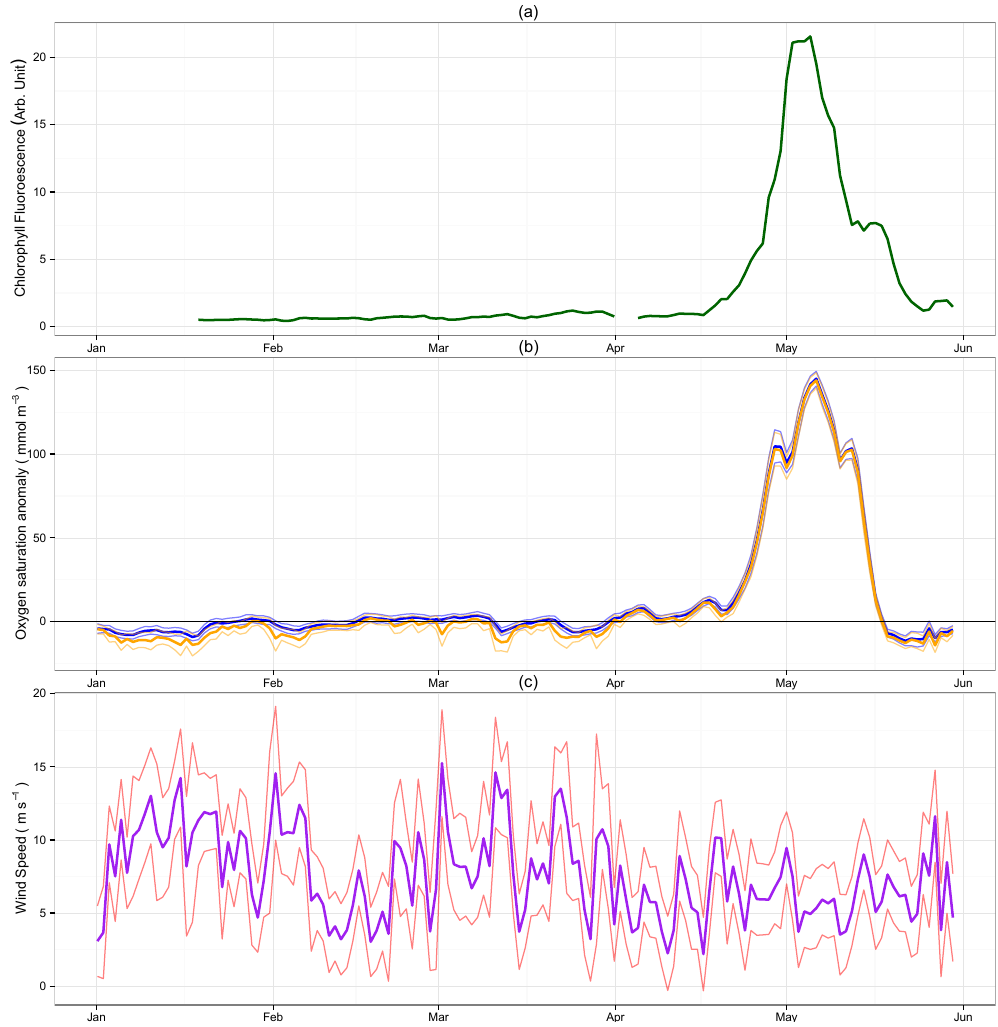
Figure 3. Spring 2008 Warp Anchorage time series. (a) Chlorophyll fluorometry. (b) Oxygen saturation anomaly (oxygen concentration mi- nus the solubility). Orange and blue lines represent oxygen saturation anomaly with and without bubble supersaturation effects respectively. (c) ECMWF MACC reanalysis 10m wind speed. For (b) and (c) thin lines represent 2 σ confidence